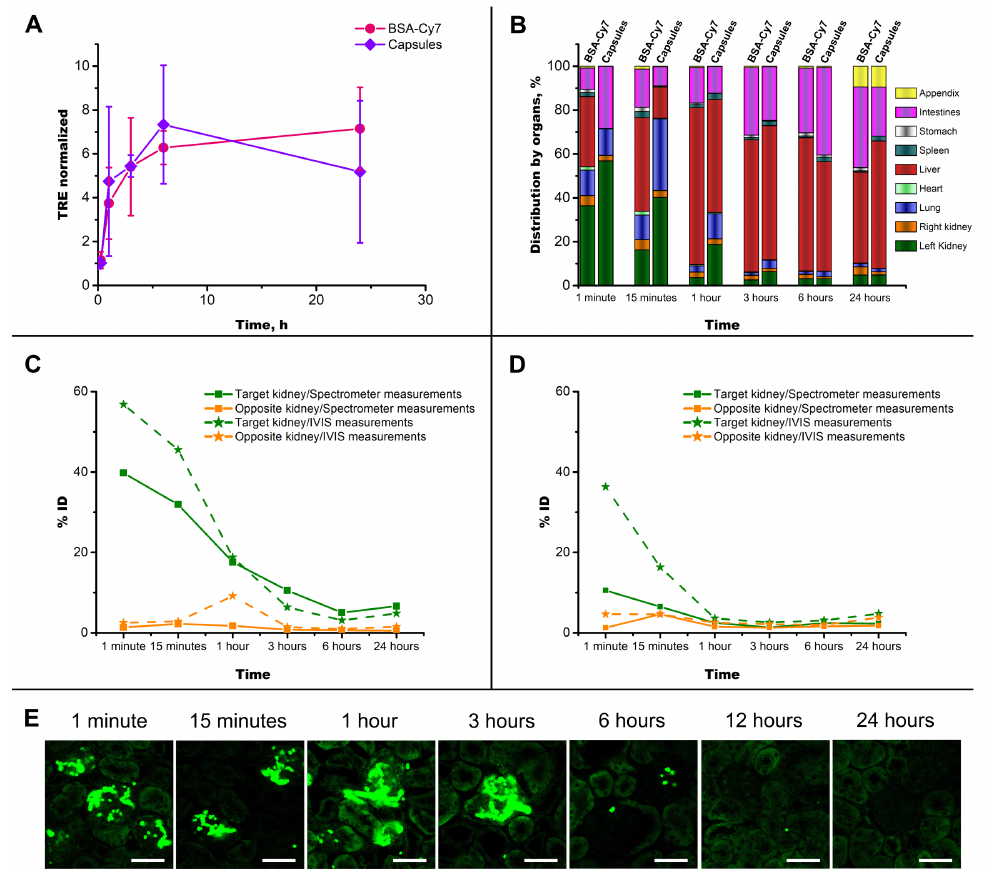
Figure 5. Biodistribution of fluorescent dye (Cy7) after intra-arterial injection of capsules labeled with BSA-Cy7 and its free solution ( A – D ). Time dependence of integrated total radiant efficiency by all dissected organs ( A ). Kinetics of the biodistribution of Cy7 ( B ). Time dependence of Cy7 content in the kidneys expressed as a percentage of injected dose after administration of capsules labeled with BSA-Cy7 ( C ) and free BSA-Cy7 conjugate ( D ). Fluorescent microscopy of the kidney’s cryosections after 10 × 10 6 capsules’ injection ( E ). The detection channel was adjusted to RITC fluorescence. The scale bar is 50 µ